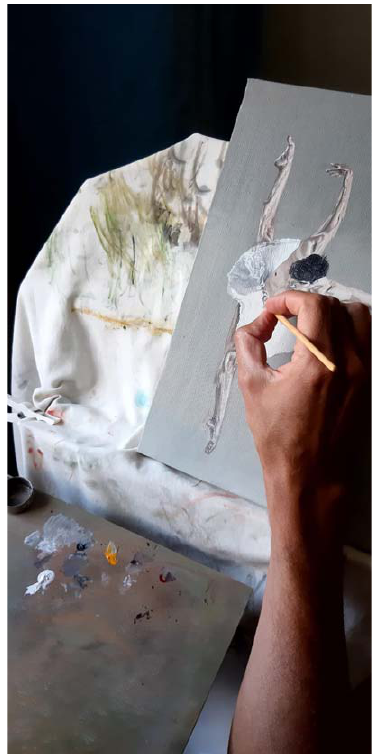
Figure 5. Auricolari per smartphone, 2020; © Coco